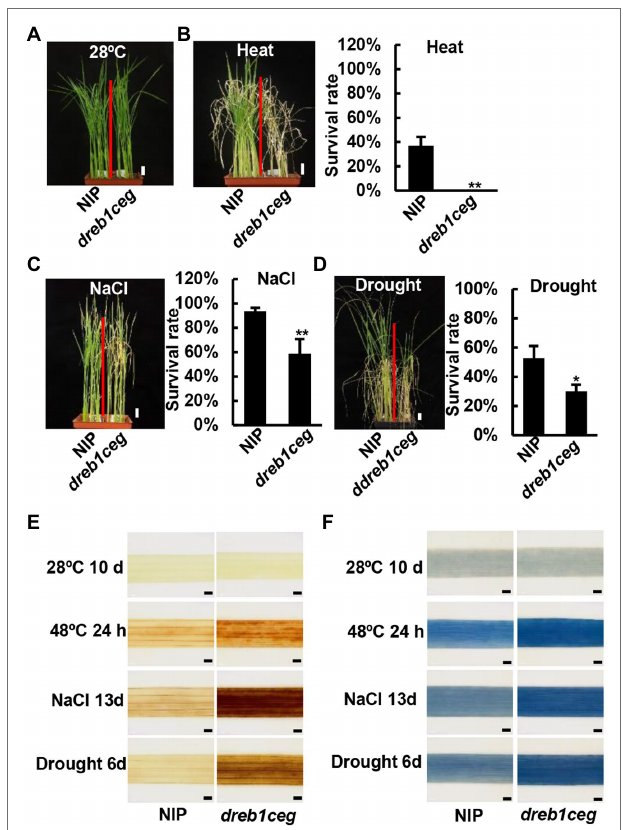
FIGURE 6 | The dreb1ceg mutant is more susceptible to heat, salt and drought stress at seedling stage. (A) Growth phenotype of NIP and dreb1ceg under control condition of 28 ° C. (B) Growth phenotype and survival rates of NIP and dreb1ceg after heat treatment (48 ° C for 2 days) and 7-day recovery growth at 28 ° C. (C) Growth phenotype and survival rates of NIP and dreb1ceg after salt treatment (200 mM NaCl) for 23 days. (D) Growth phenotype and survival rates of NIP and dreb1ceg after drought treatment for 10 days followed by a 7-day recovery. (E,F) DAB (E) and trypan blue (F) staining of the second leaves of NIP and dreb1ceg under control condition (28 ° C), heat (48 ° C for 24 h), salt (200 mM for 13 days), and drought stress (6 days of water withheld). Bars in plant images represent 2 cm, and bars in staining images represent 1 mm. Survival rates in (B–D) are expressed as mean ± SD from three biological replicates. * and ** indicate significant differences at p < 0.05, and p < 0.01, respectively, by Student’s t